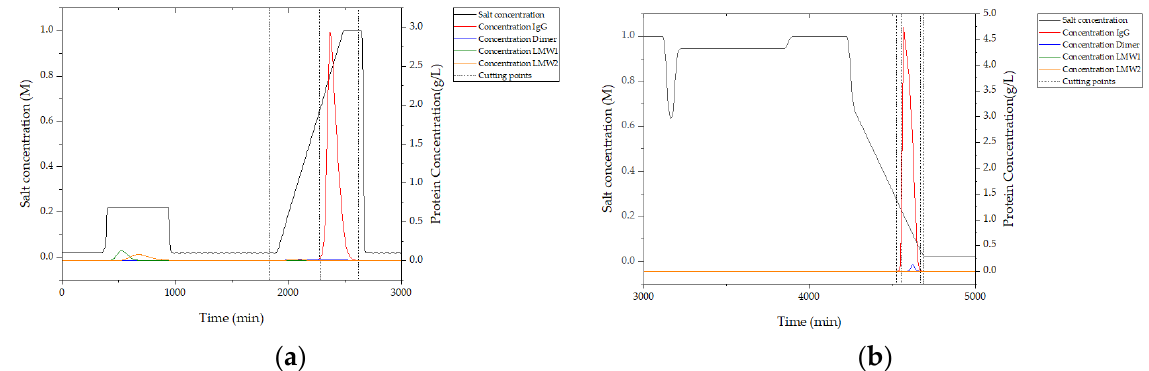
Figure 16. Simulation results of integrated counter current chromatography (iCCC); ( a ) is ion exchange chromatography (IEX) after five cycles, ( b ) is hydrophobic interaction chromatography (HIC) after five cycles.